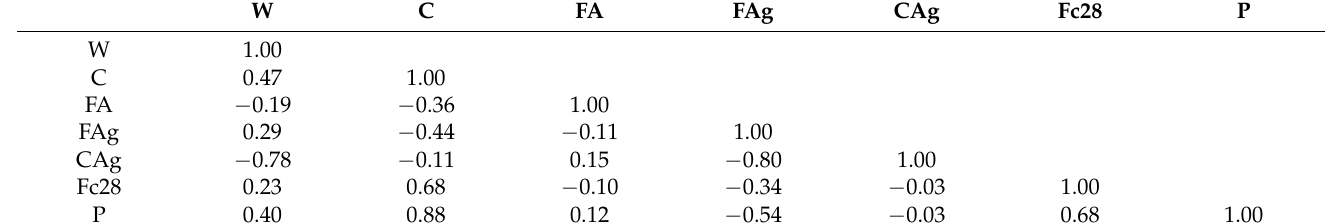
Table 3. Pearson correlation matrix of the FA–concrete parameters.